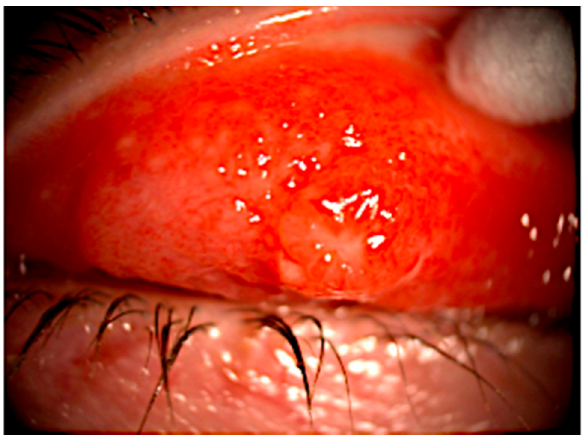
Figure 2. Granuloma in upper tarsal conjunctiva with surrounding papillary reaction in a case of CSD POGS (case #8 [19]).